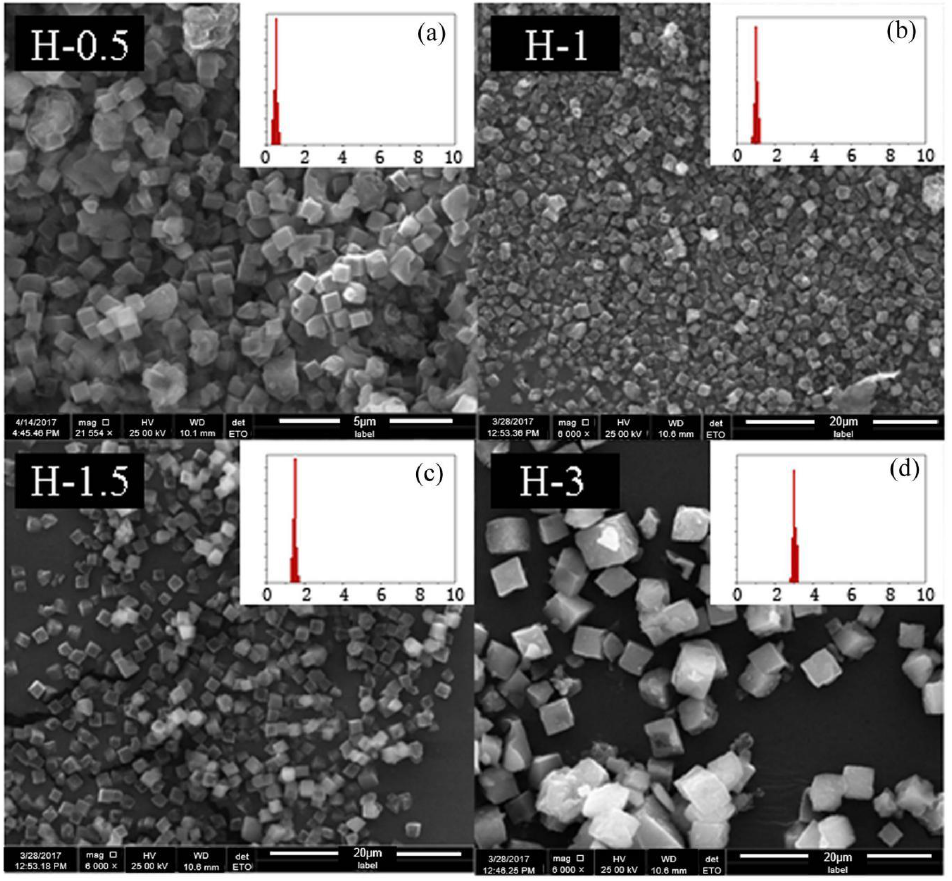
Figure 11. The SEM results of SSZ-13 with different sizes (Si/Al = 8). ( a ) H-0.5; ( b ) H-1; ( c ) H-1.5; ( d ) H-3. Synthesized gel compositions: 1 SiO 2 : 0.06 Al 2 O 3 : 0.05 Na 2 O: 0.2 SDA: 20 H 2